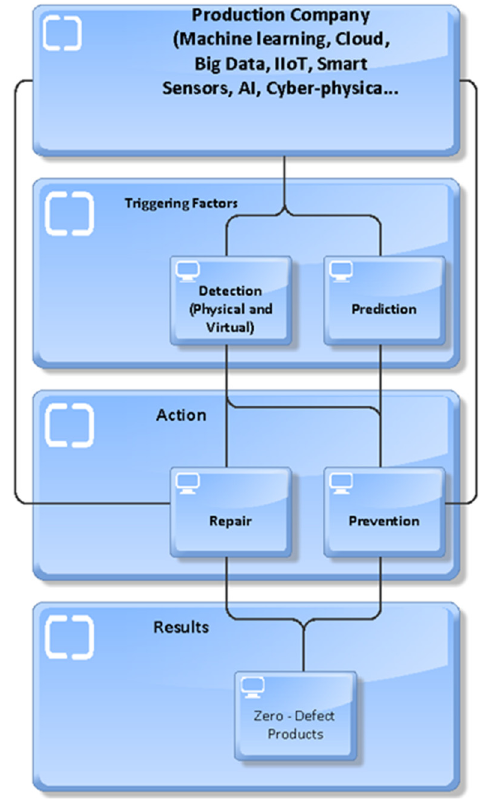
Figure 2. Classical Zero-Defect Manufacturing Framework.